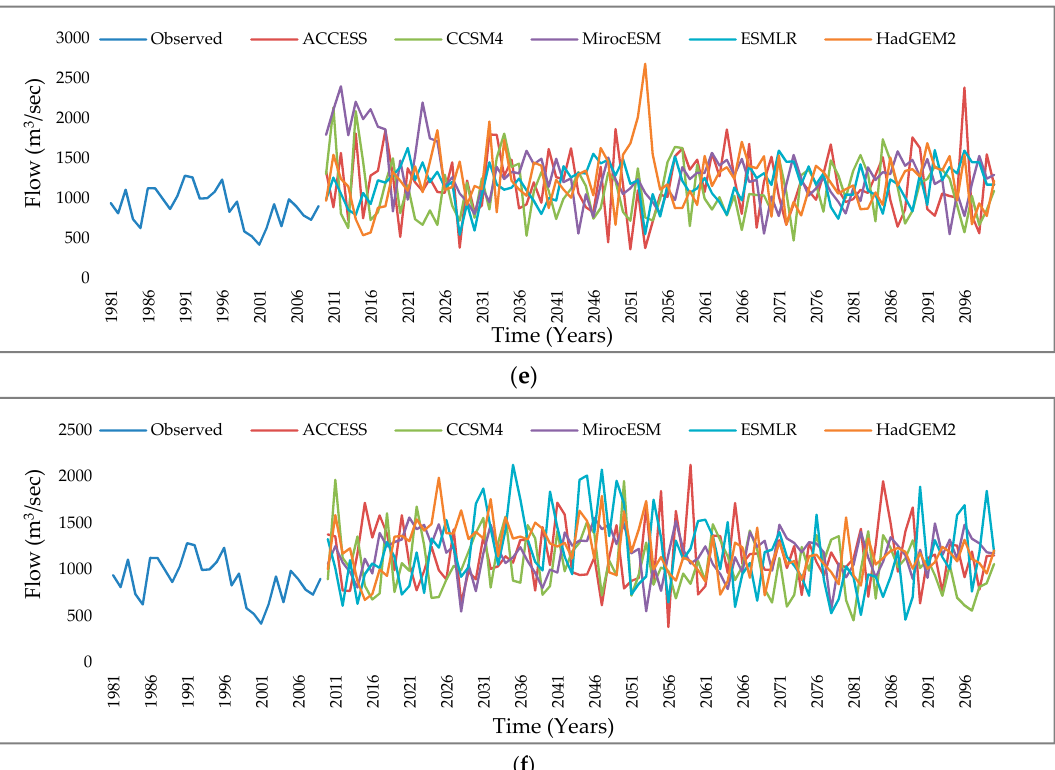
Figure 12. Comparison of different downscaling techniques in regard to average annual flow under